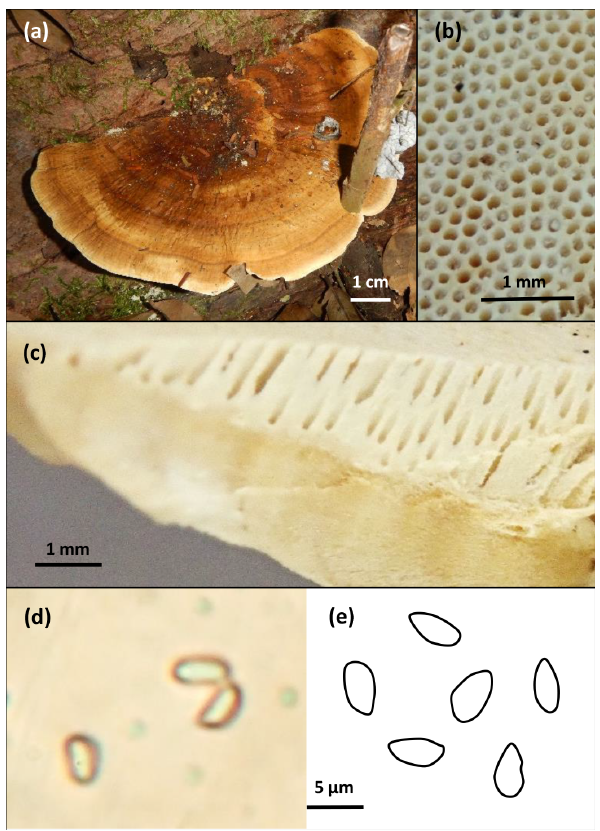
Figure 2. Photographic documentation of the measured basid- iomycete Rigidoporus microporus . (a) Sessile basidioma growing on a dead hardwood, (b) polyporoid hymenium with white sur- face, (c) vertical cross-section of hymenium with homogeneous content, (d) microscopic image of the one-celled colorless spores at 1000 × magnification, and (e) schematic drawing of some of the observed spores, average size 3µm × 5µm. Scales indicated.